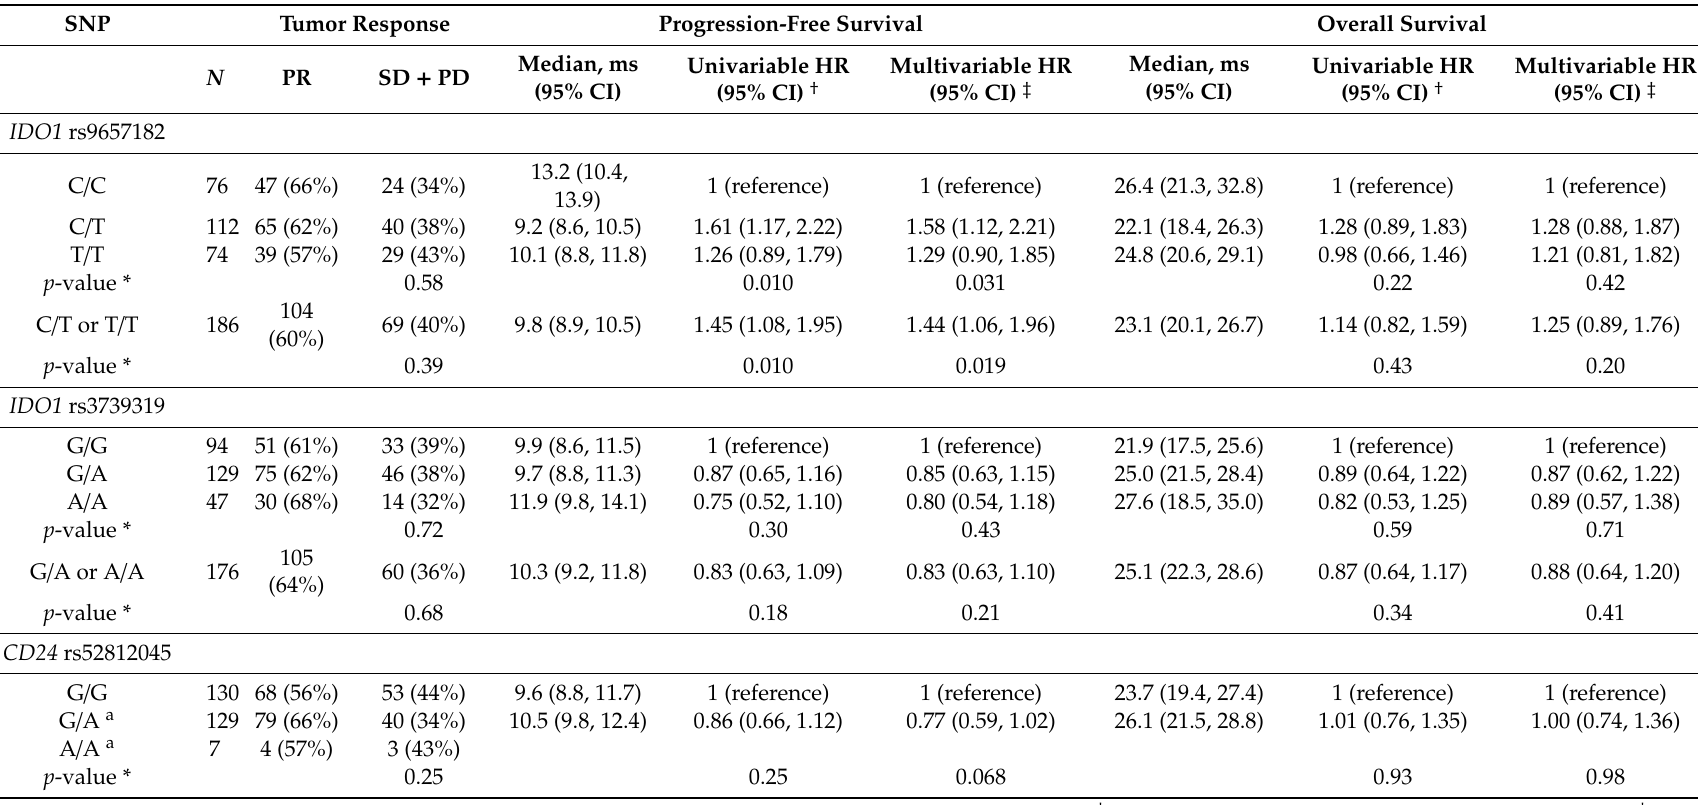
Table 5. Immune regulatory SNPs and outcomes in patients treated with first-line FOLFIRI and bevacizumab in FIRE-3 (control cohort